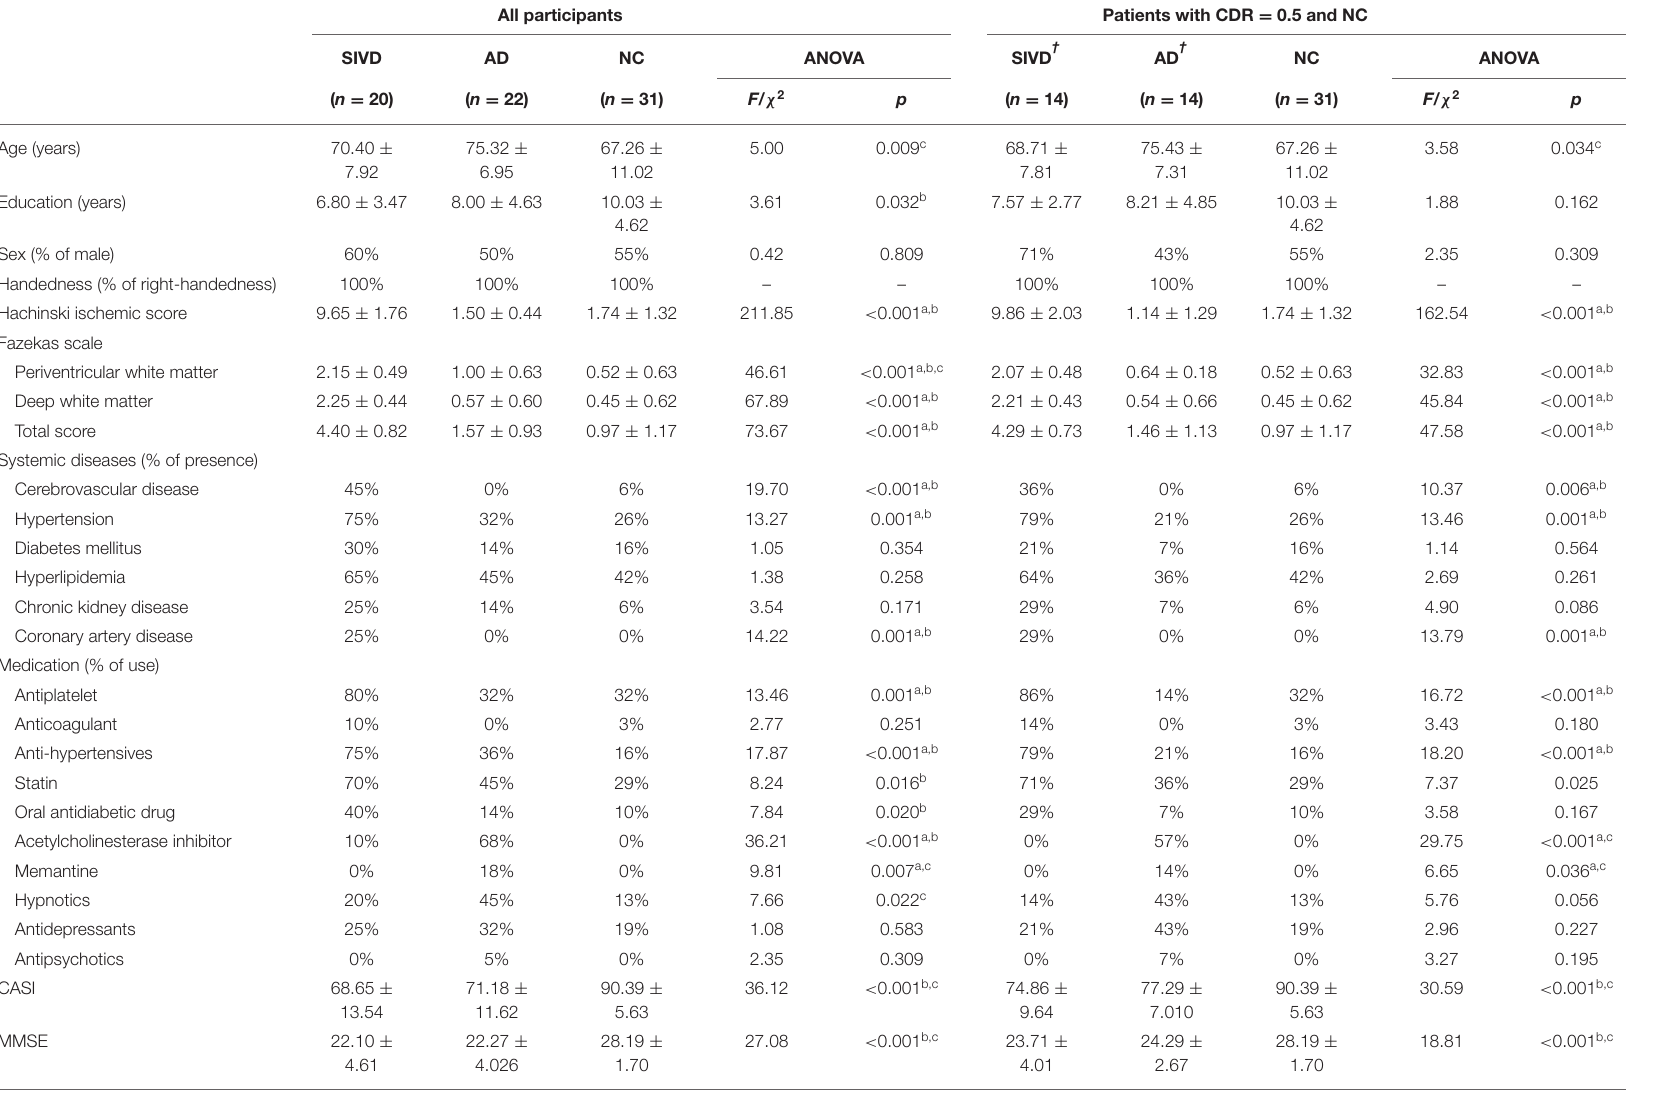
TABLE 1 | Basic information of the participants. All participants Patients with CDR = 0.5 and